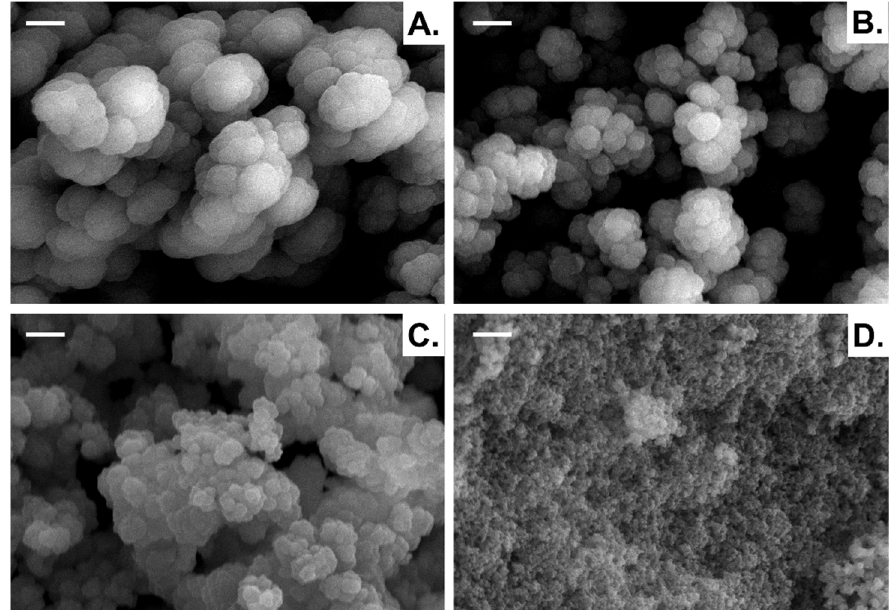
Figure 3. SEM micrographs of monoporous poly(VMA- co -EGDMA) materials prepared from 70/30 mol.% VMA/EGDMA and 80 vol.% MeOH ( A ), EtOH ( B ), i -PrOH ( C ) or EtOAc ( D ) with respect to the total volume of co-monomers. Scale bar = 1 µm.